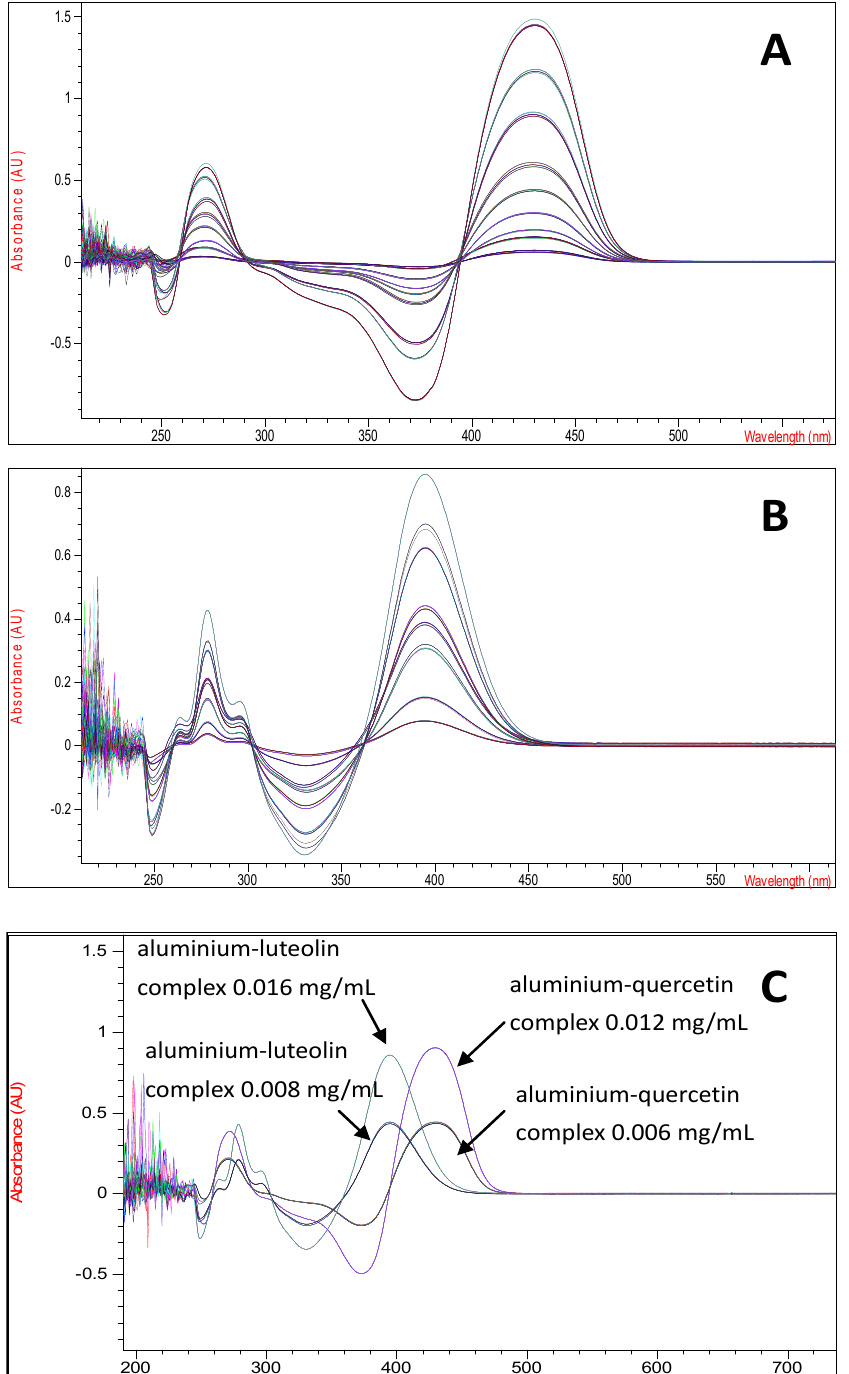
Figure 1. ( A ) The UV spectrum of aluminium-quercetin complex at various concentrations (0.0004–0.02 mg/mL), ( B ) the UV spectrum of aluminium-luteolin complex at various concentrations (0.0016–0.016 mg/mL) and ( C ) the UV spectrum of aluminium-quercetin complex at concentrations of 0.006 and 0.012 mg/mL and aluminium-luteolin complex at concentrations of 0.008 and 0.016